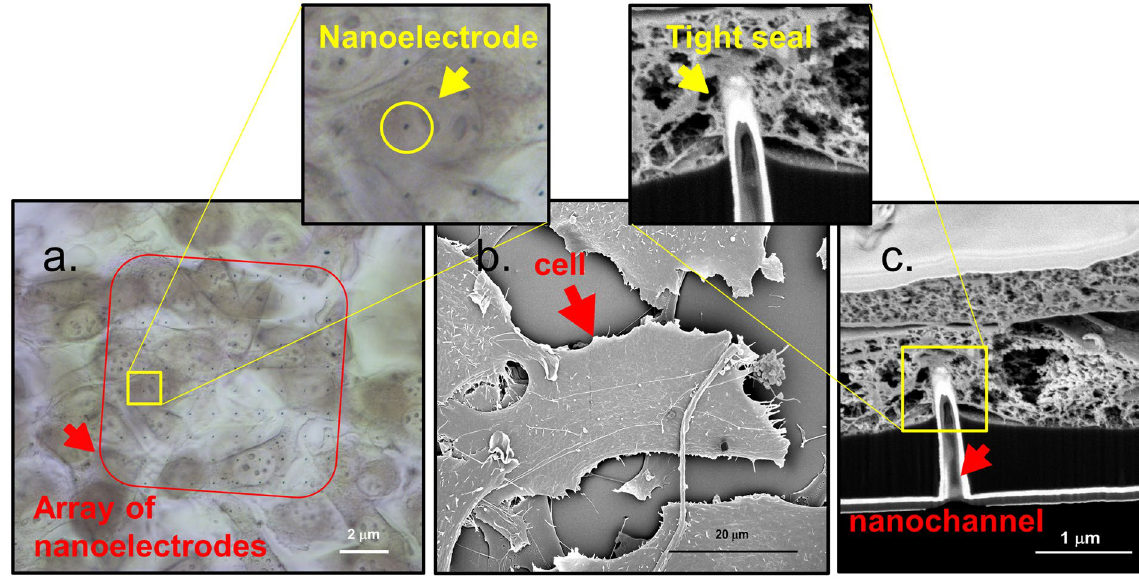
Figure 3. ( a ) Transmission image of NIH-3T3 cells fixed on an array of hollow nanoelectrodes – the black dots inside the red square – embedded in SU8. ( b ) SEM top view image of CPD dried NIH-3T3 cells cultured on top of the hollow nanoelectrodes. ( c ) Cross section of CPD dried cell grew on top of a hollow nanoelectrode. From this image it is possible to see all the layers of the fabrication (Si 3 N 4 membrane 100 μ m thick, SU8) and the hollow 3D nanoelectrode that is engulfed by the cellular membrane.